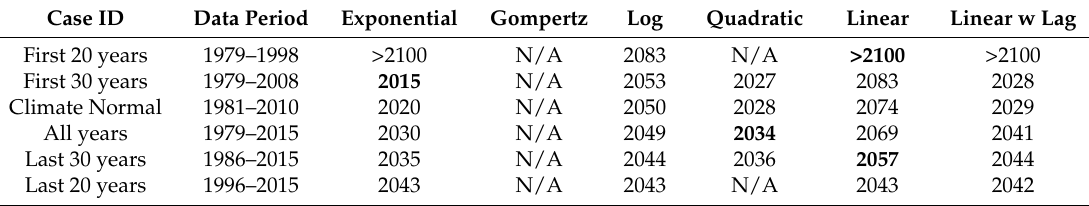
Table 5. Projected first Arctic zero-crossing summer years from optimized statistical models. Entries in bold indicate projections from models with the best fit (see AICc and W information from Table